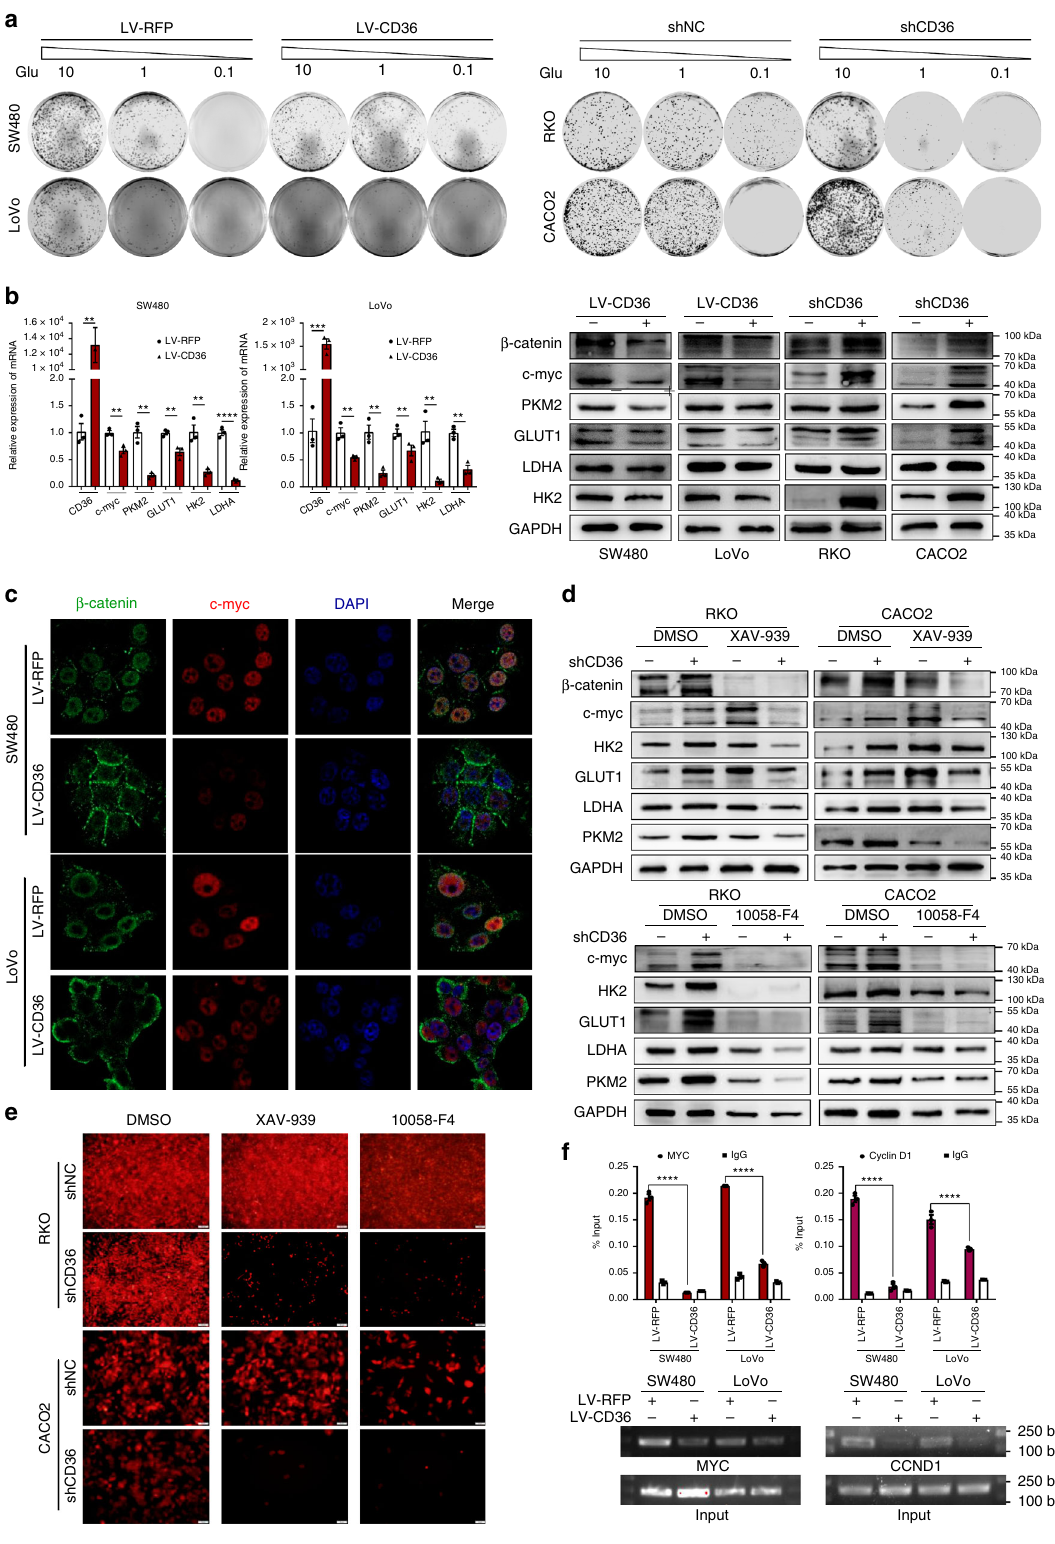
Fig. 3 CD36 inhibits glycolysis via suppressing β -catenin/c-myc. a Colony formation assays to test cell viability under different glucose deprivation. b qRT- PCR and western blots of target genes in indicated cell lines. Results are shown as mean ± SEM ( n = 3), ** P < .01, *** P < .001, **** P < .0001, based on Student ’ s t -test. c IF staining of β -catenin (green) and c-myc (red). Merged images represent overlays of β -catenin, c-myc and nuclear staining by DAPI (blue). d Western blots of indicated proteins in cells treated with β -catenin inhibitor XAV-939 (10 μ M, 72 h) and c-myc inhibitor 10058-F4 (25 μ M, 96 h), respectively. e Images of cells with shCD36 or shNC under treatment of XAV-939 (100 μ M, 36 h) or 10058-F4 (200 μ M,36 h). Scale bar, 100 μ m (10 ×). f ChIP-qPCR and PCR analysis of β -catenin with MYC and Cyclin D1 promoter regions. Data are shown as fold enrichment relative to input, **** P < .0001, mean ± SEM ( n = 3), based on Student ’ s t -test. Source data are provided as a Source Data fi